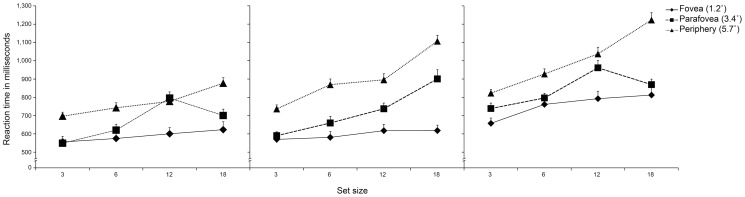
Experiment 2: Reaction times (RTs) in milliseconds (ms) to detect the target picture - snake (left panel), spider (middle panel), and mushroom detection (right panel), as a function of set size (3, 6, 12, 18) and location in the visual field (fovea, parafovea, periphery).